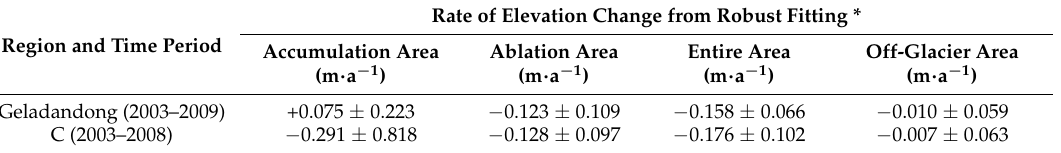
Table 1. Rates of glacier elevation changes by robust fitting.